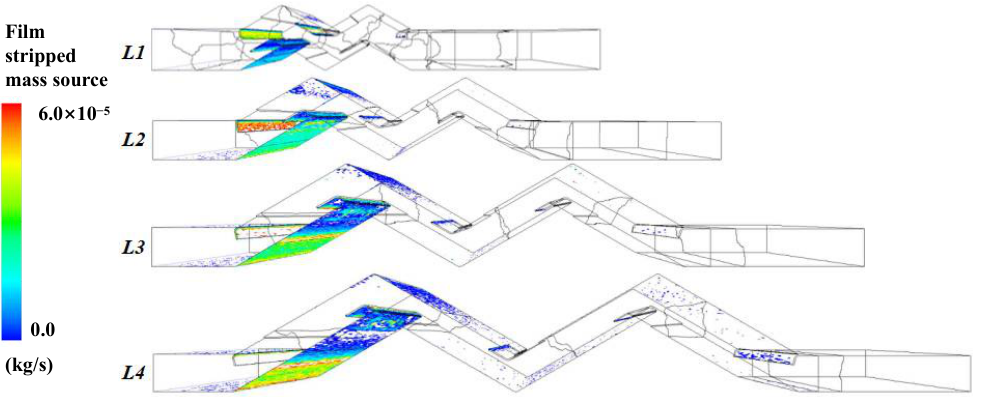
Figure 14. 3D film stripped mass source contour under inlet velocity U g = 12.00 m/s in different wavelengths.